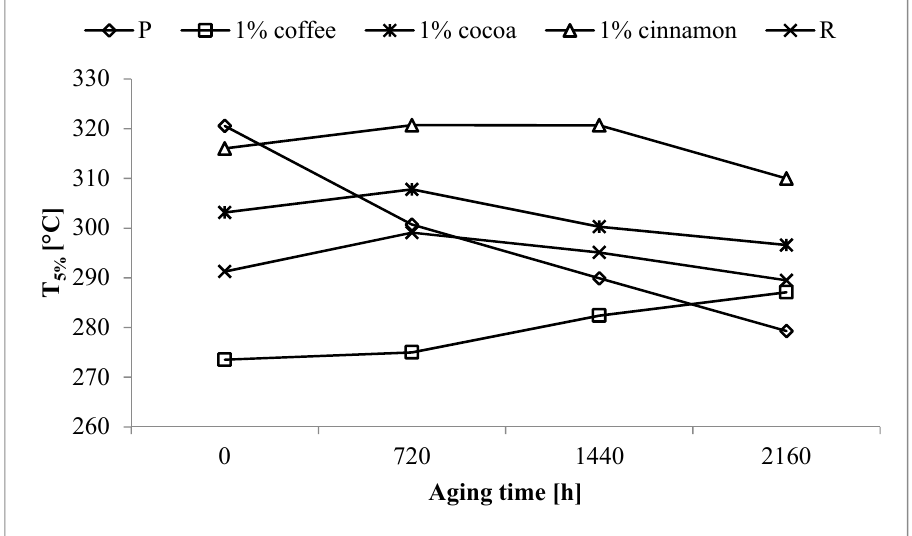
Figure 3. Changes in the temperature of 5% of mass loss (T 5% ) of selected samples as a function of aging time.